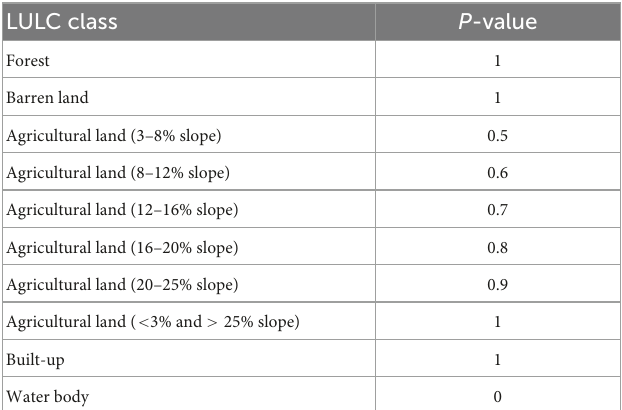
TABLE 3 P -values for different LULC classes (complied after Wischmeier and Smith, 1978; Wanielista and Yousef, 1993; Londhe et al., 2010). LULC class P